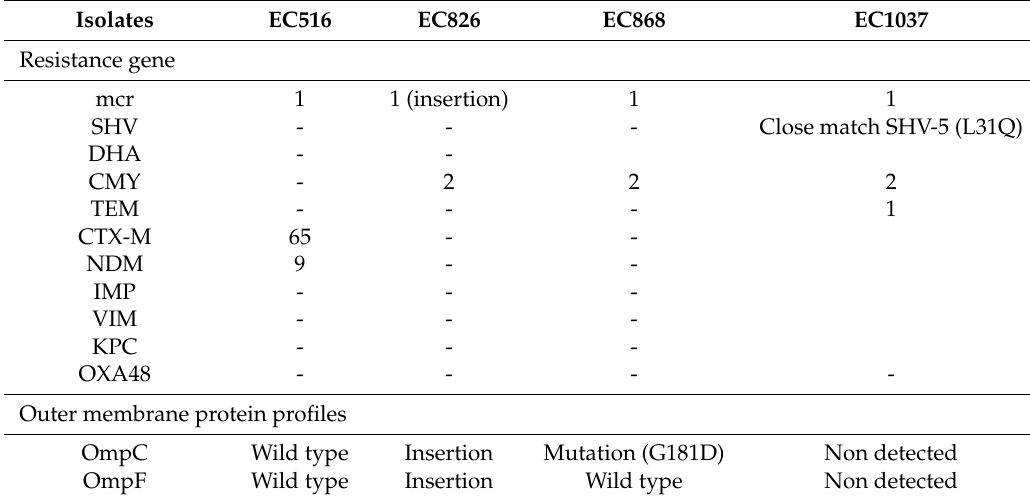
Table 3. Antibiotic resistance mechanisms of mcr-1 -positive Enterobacteriaceae isolates.